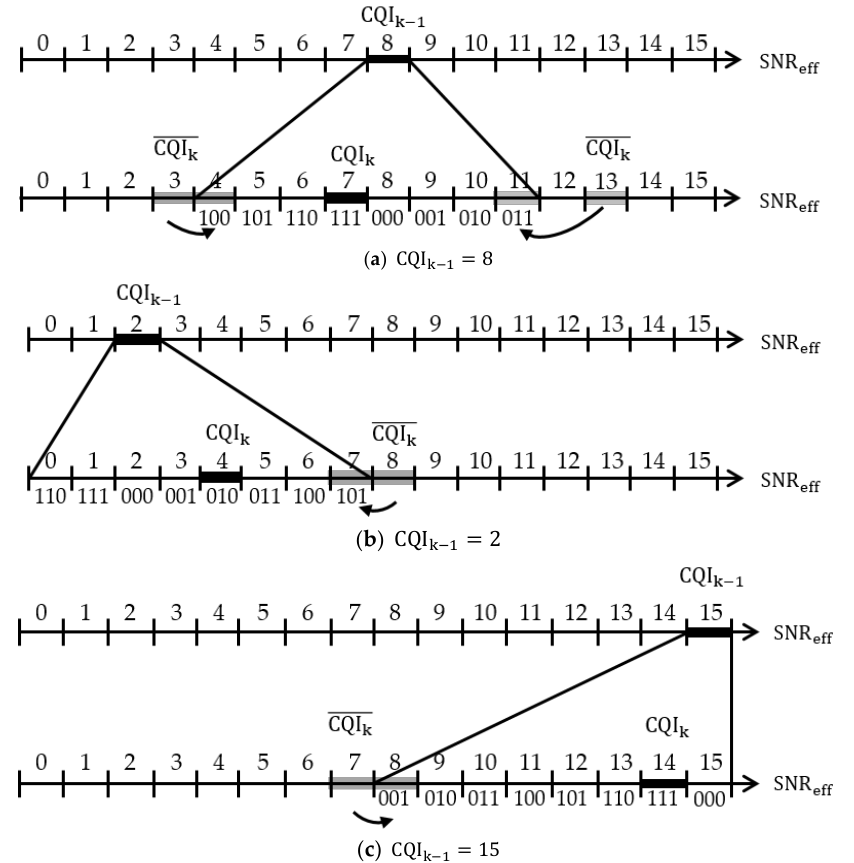
Figure 2. Examples for the process of the 1-bit reduction scheme of channel quality indicator (CQI) feedback. (CQI)